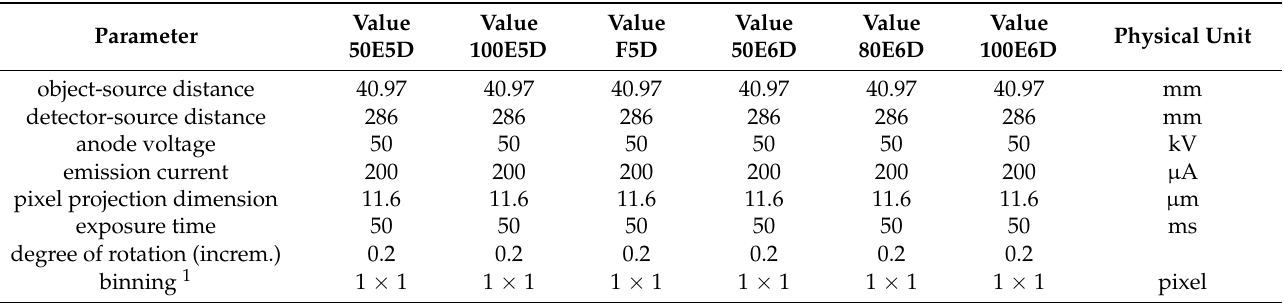
Table A2. Values of set parameters on SkyScan 1275.